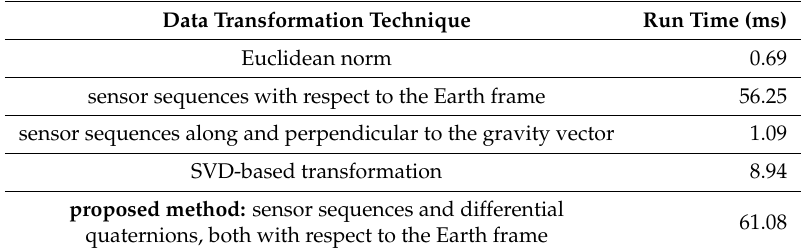
Table 2. Average run times of the data transformation techniques per 5-s time